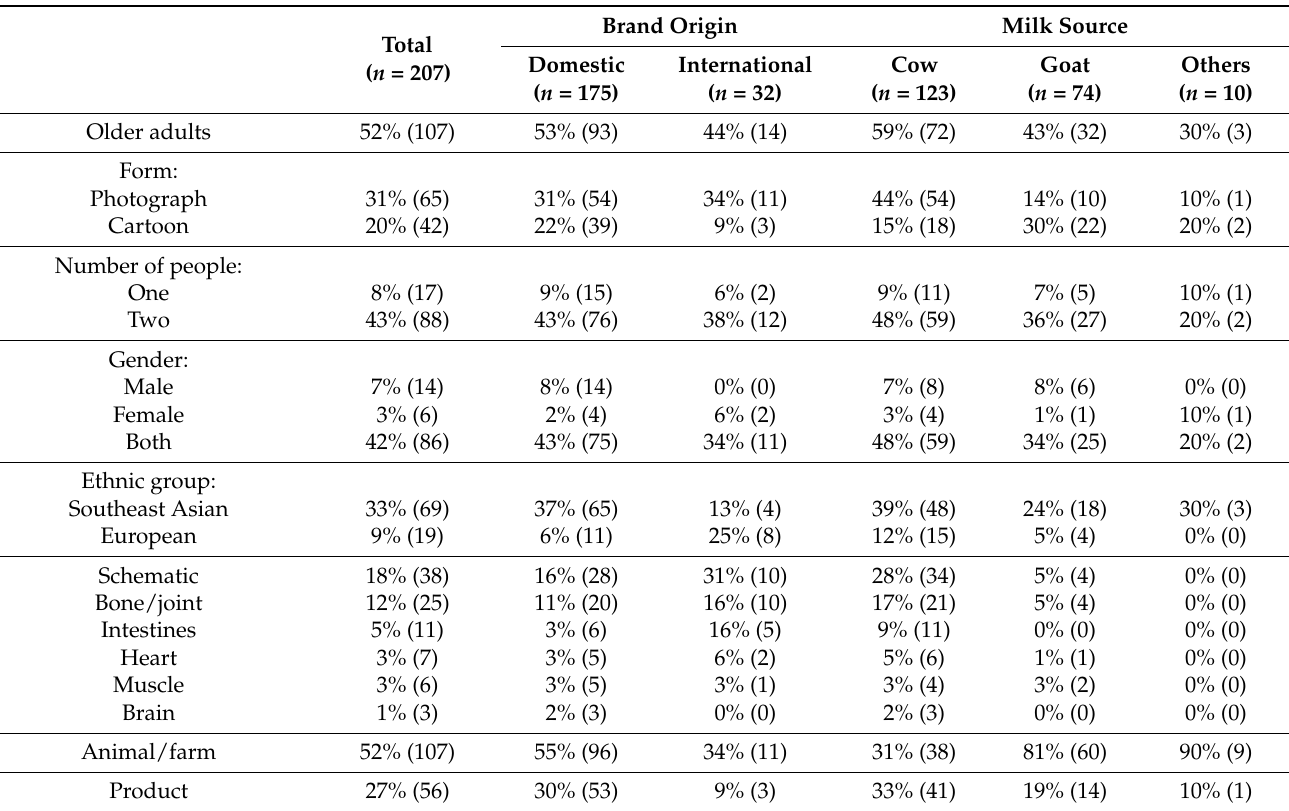
Table 6. Percentage and number of milks targeting Chinese older adults providing graphical volun- tary well-being messaginging by total, brand origin and milk source 1 . Brand Origin Milk Source Total ( n = 207)